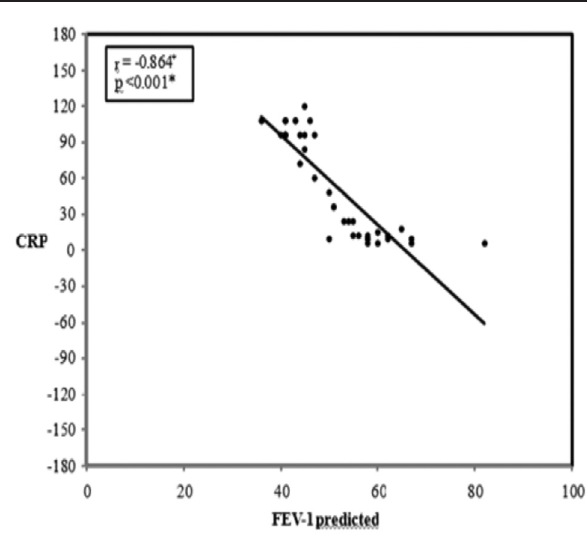
difference between patients with moderate COPD and control group ( P = 0.048) and between patients with severe COPD and control group regarding